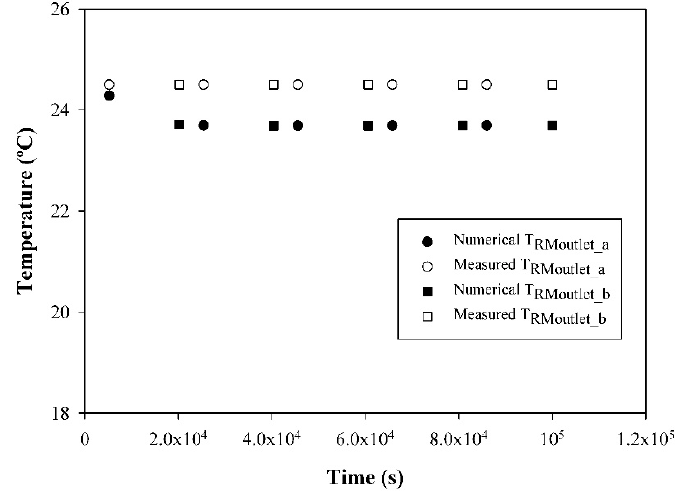
Figure 5. Water outlet temperature of rolling mill ( T RMoutlet ).